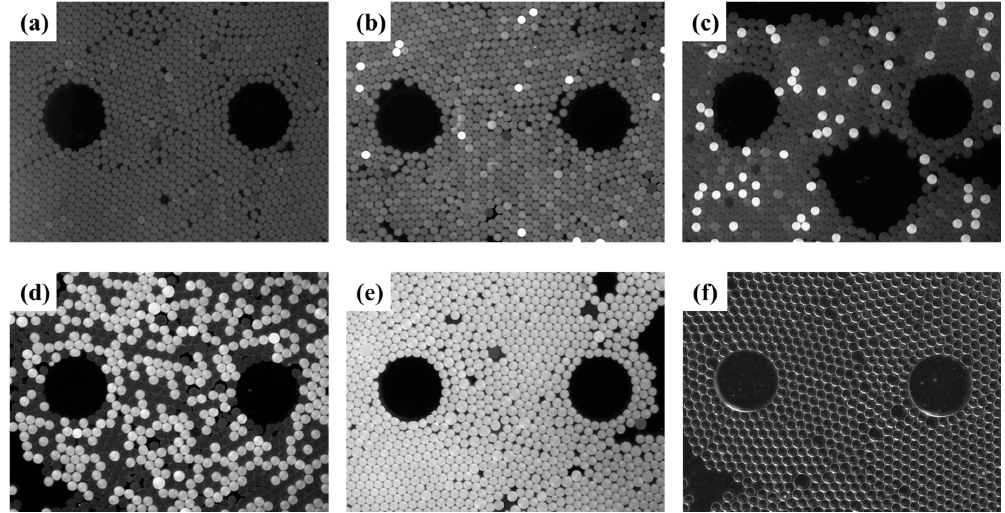
Figure 9. Digital LAMP assessments as varying concentrations of HBV DNA. ( a ) Negative control. ( b – e ) Digital LAMP fluorescent images (partially shown) for serially diluted samples of HBV DNA